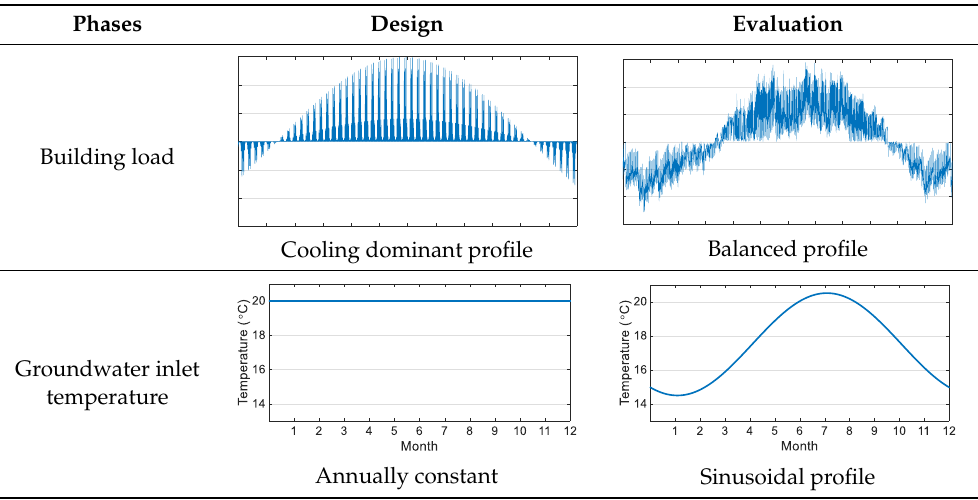
Figure 4. Source-side configuration of the permanent dewatering coupled heat pump (PDHP) system.